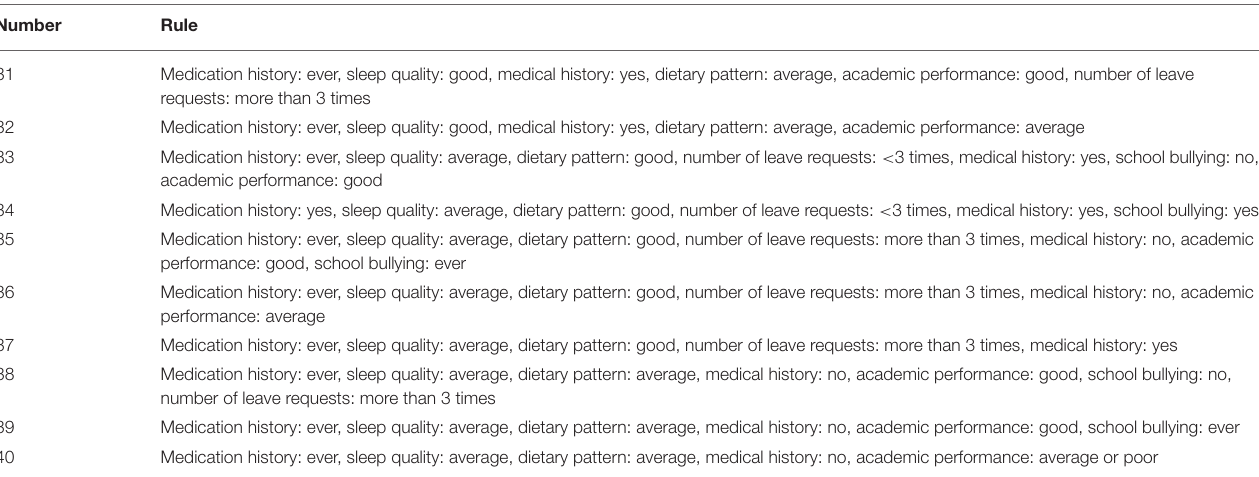
TABLE 7 | Psychological crisis judgment Table 4 .